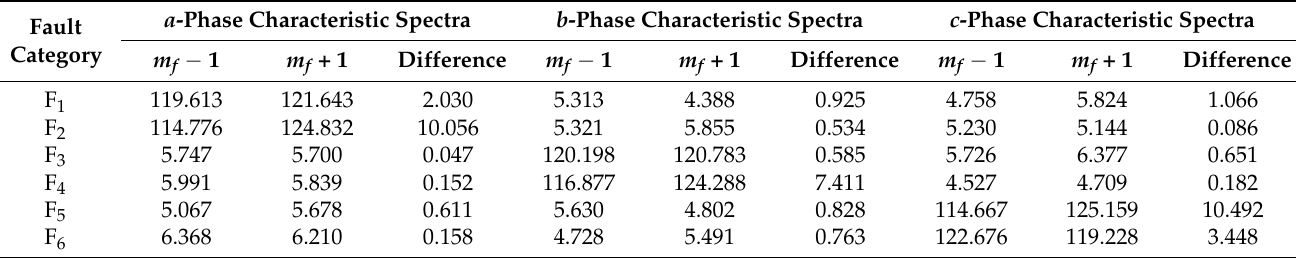
Table 2. Characteristic spectral data of the inverter at 52 Hz with different fault categories.